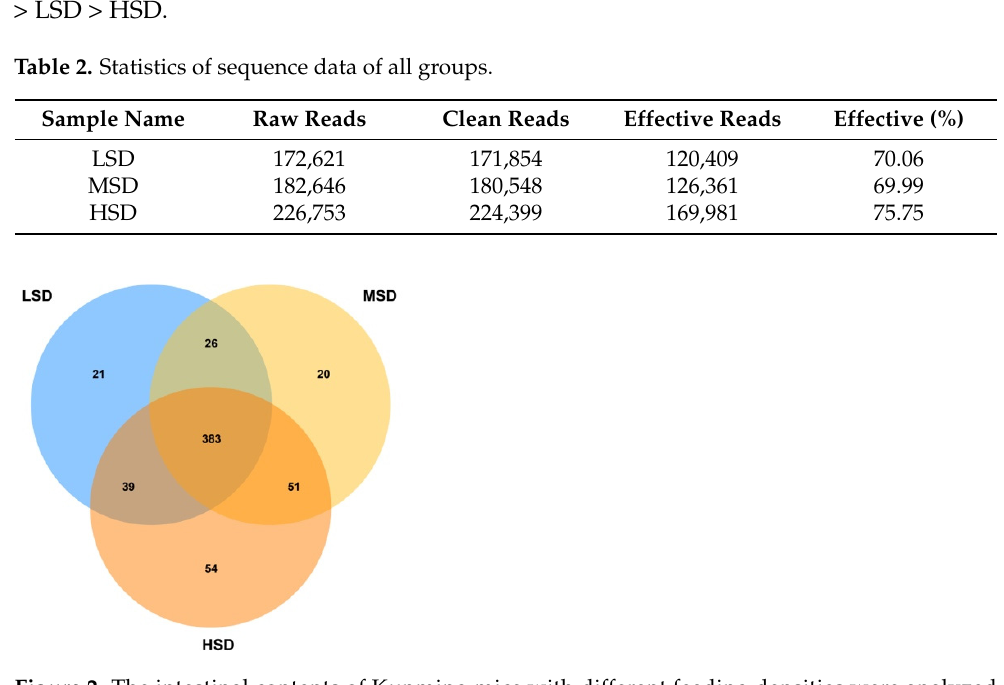
Figure 1. Growth performances of Kunming mice reared in different stocking density groups. Date presented as mean ± SD.